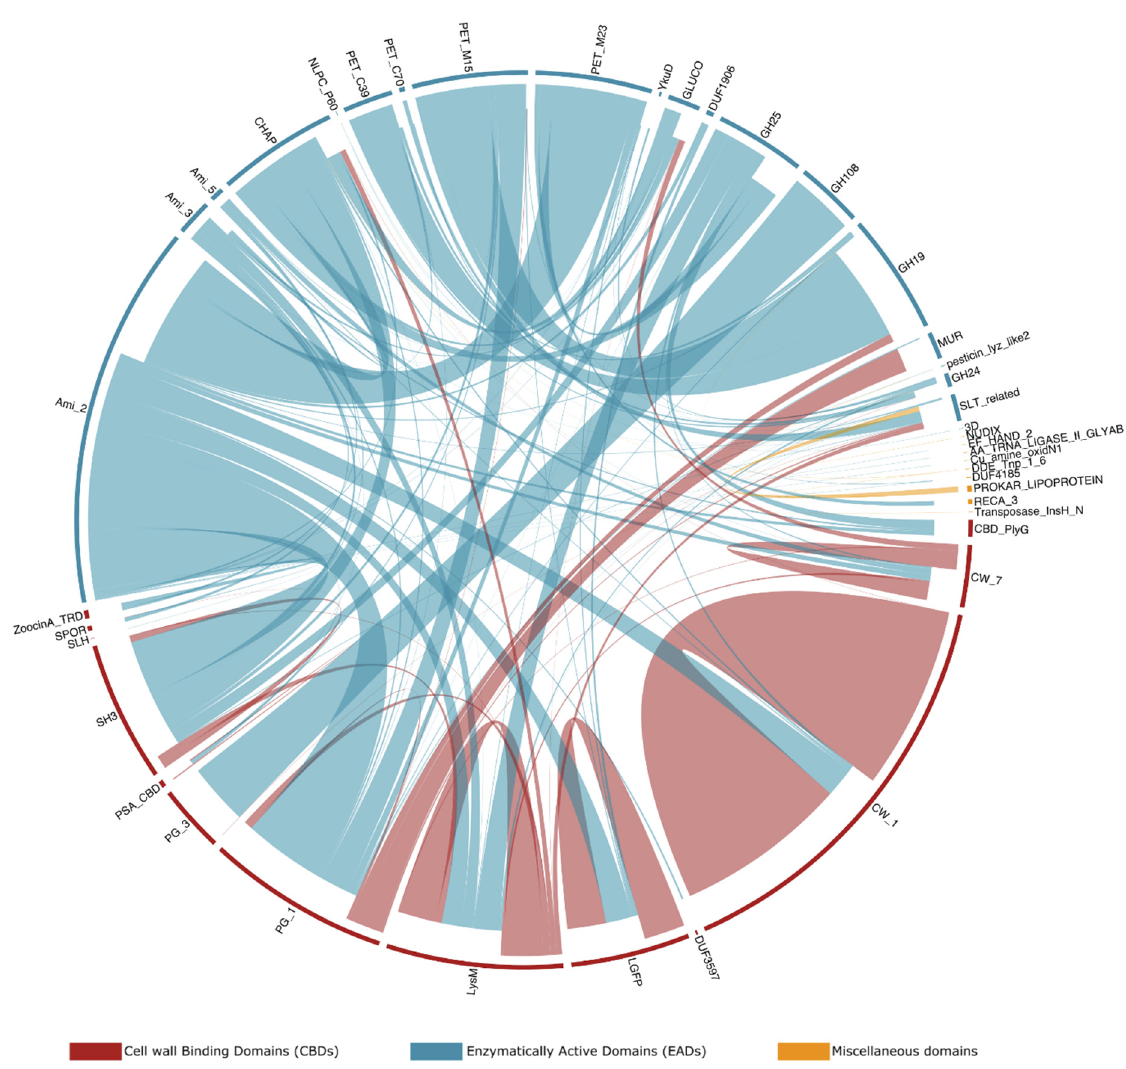
Figure 6. Frequency of occurrence of adjacency of domains in endolysins. Connections are drawn for two domains if they appear consecutively in at least one entry in PhaLP. The frequency of observation of each connection is denoted by thickness. The links carry the color of the domains closest to the N-terminus and stop closer inwards of the domains closest to the C-terminus. Domains are color-coded based on their annotation as EAD, CBD or miscellaneous. Although miscellaneous domains are not expected in endolysins, the few that occur here are suspected to be yet uncharacterized CBDs/EADs or to be erroneously introduced by an incorrect delineation of the CDS in GenBank.